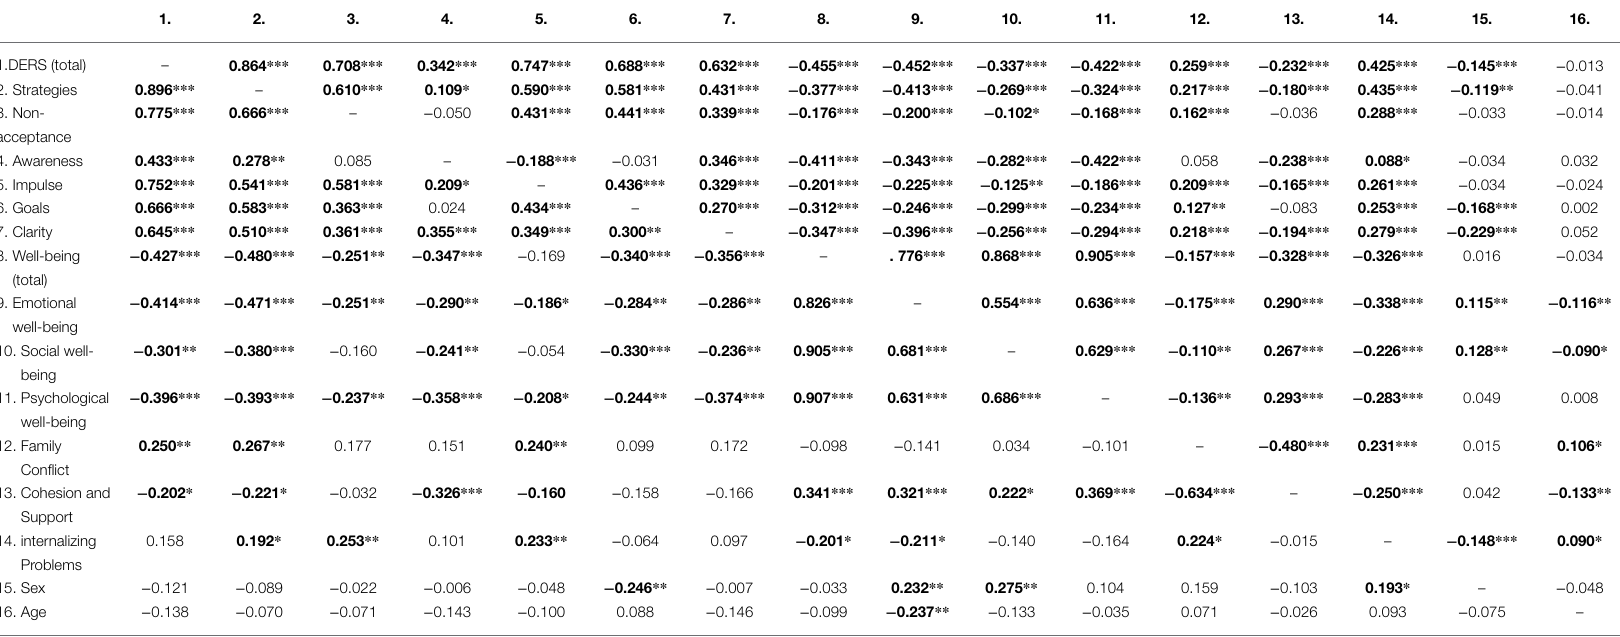
TABLE 2 | Correlations between all variables in study, in participants included in clinical ( n = 130) and nonclinical groups ( n =